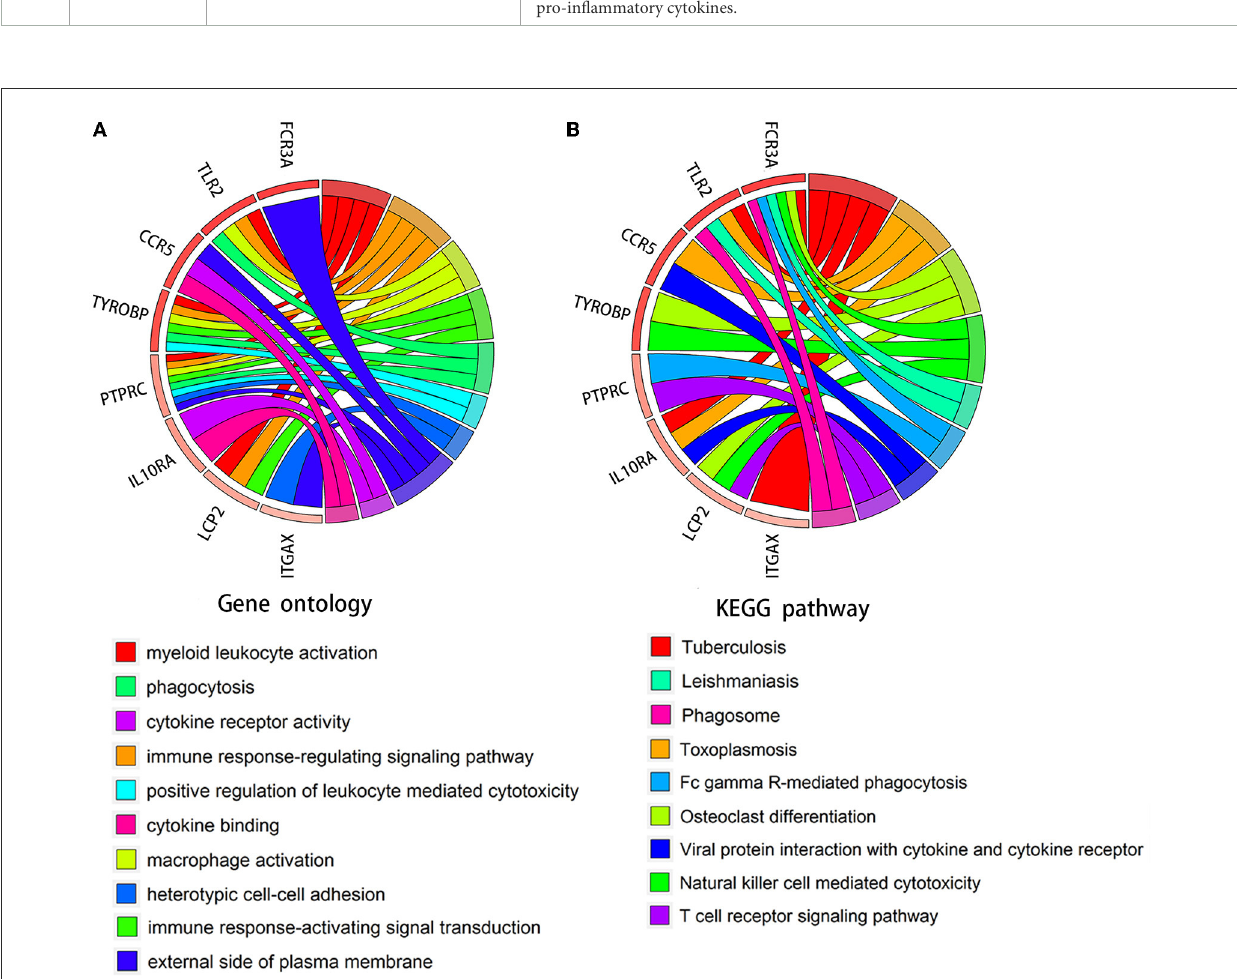
FIGURE8 Chord diagram for enrichment analysis of hub genes. (A, B) GO and KEGG analysis of hub genes. The circles on the right and left, respectively, indicate pathways and the corresponding hub